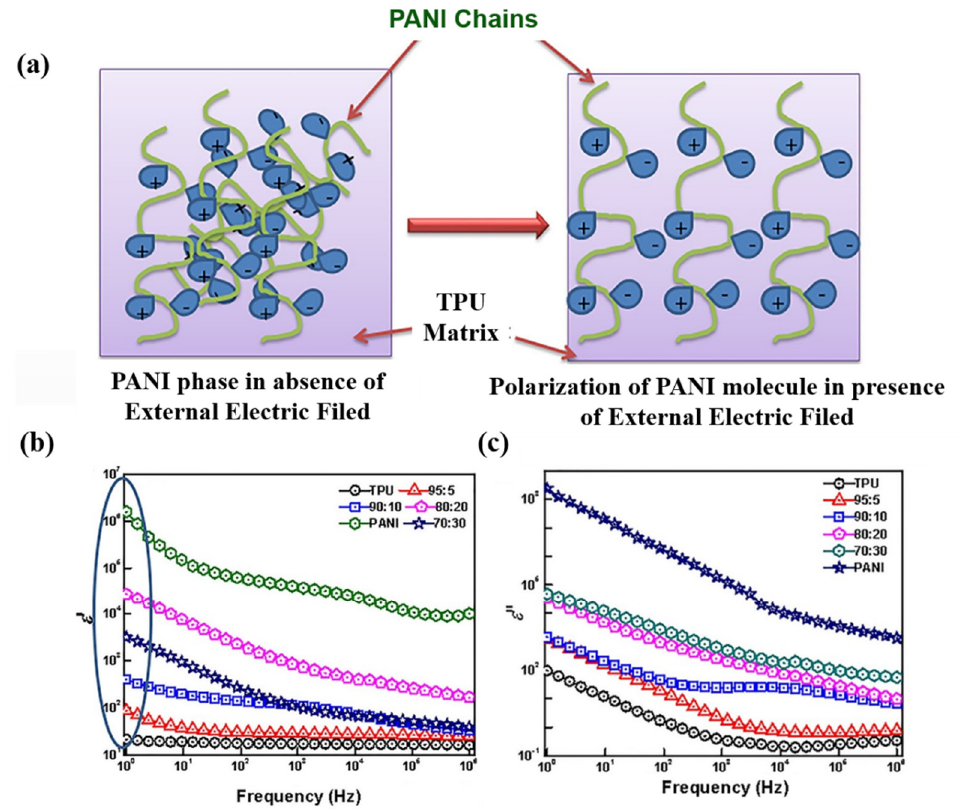
Figure 8. ( a ) Polarization of TPU/PANI composites under electric fields. The effect of PANI loading on ε′ ( b ) and ε″ ( c ). Adapted with permission [94]. Copyright 2020, Springer Nature.